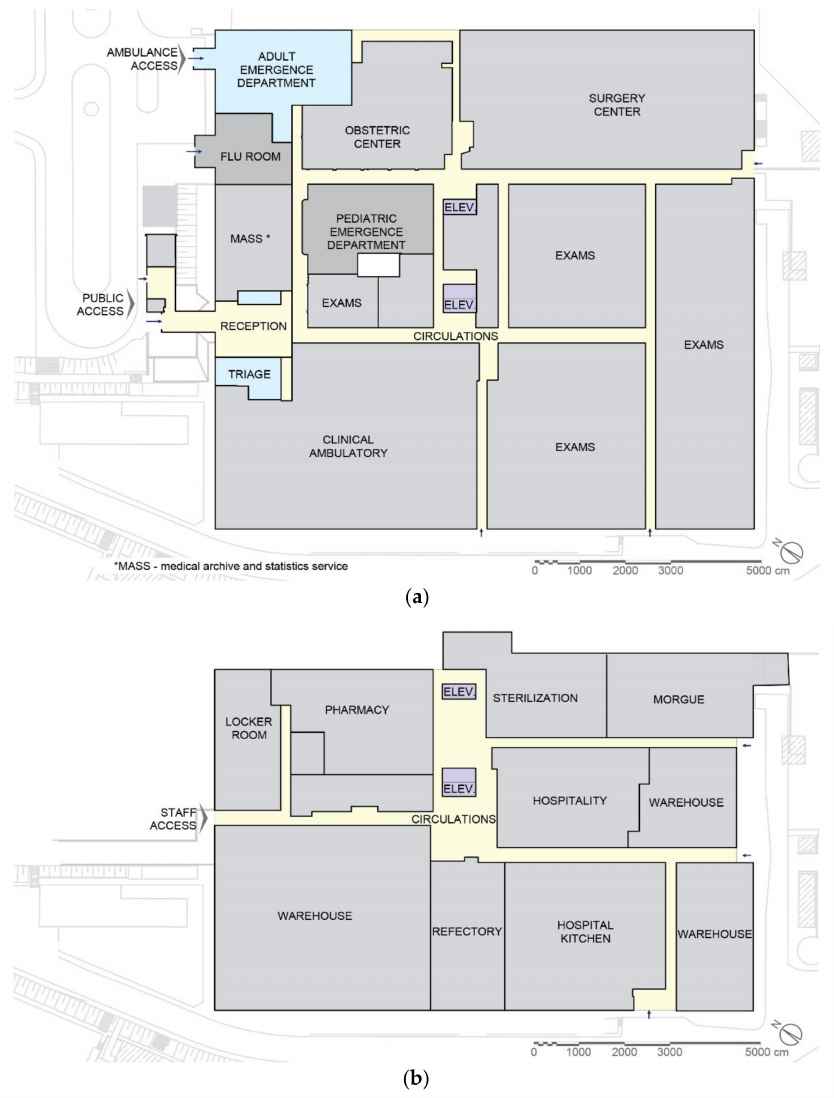
Figure 3. Scheme of the hospital’s main sectors. ( a ) Plan of the second floor; ( b ) plan of the first floor—based on Superintend ê ncia do Espaço F í sico (SEF HU USP)